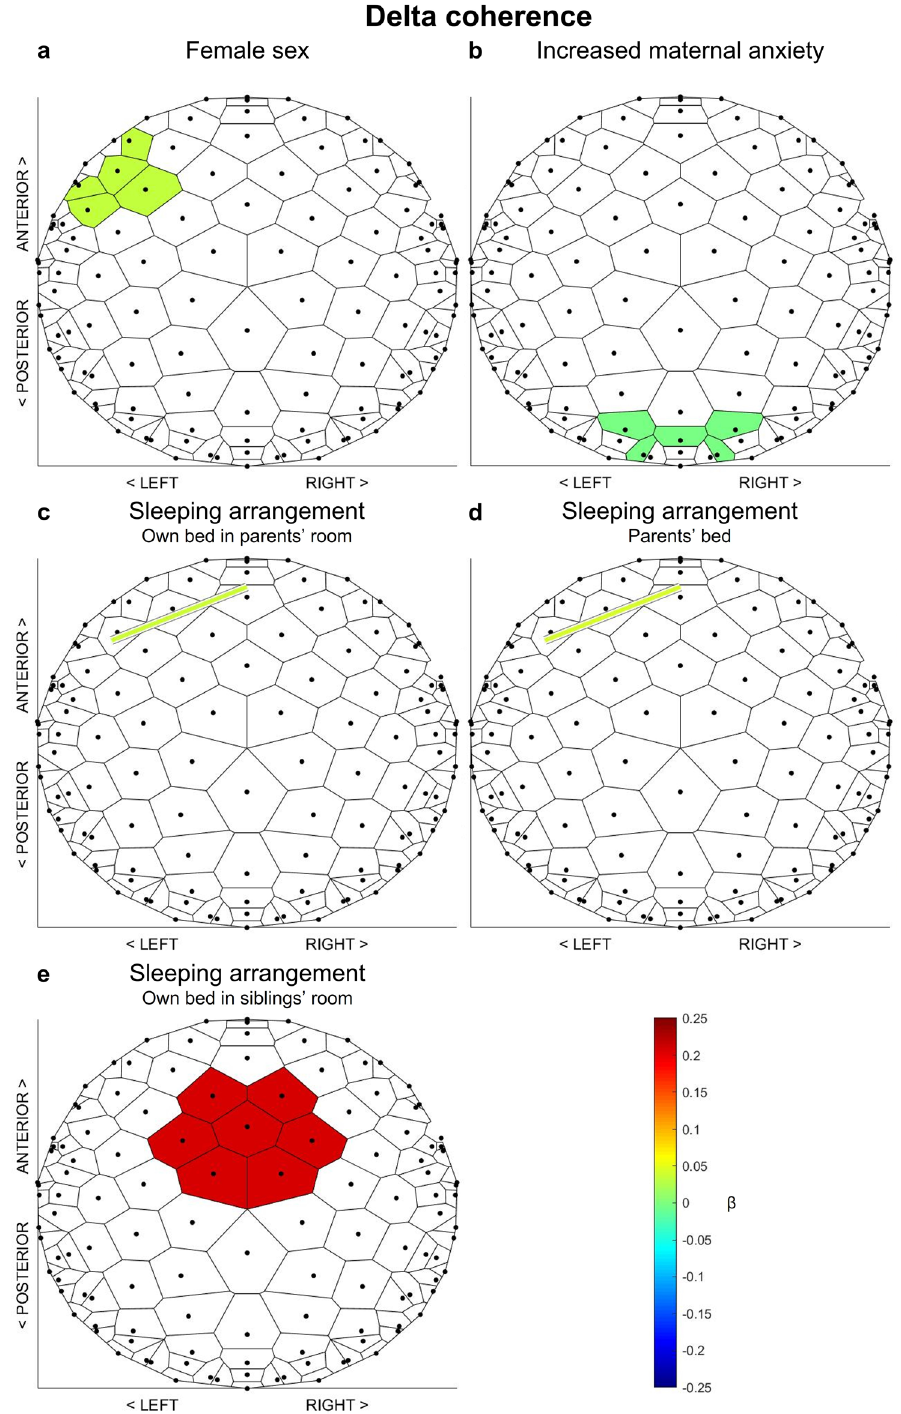
Figure 3. Significant associations of non-rapid eye movement (NREM) sleep delta coherence with sex ( a ) and familial factors ( b to e ) resulting from linear regression models. Only effects that remained significant after correcting for multiple comparisons by means of false discovery rate are shown. Colors represent the magnitude of the association as reflected in unstandardized beta coefficients. All associations were positive except for maternal anxiety where lower coherence was associated with increased maternal anxiety ( b